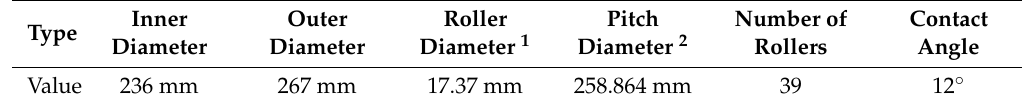
Figure 8. Two types of artificial defect on bearing: ( a ) spall on outer ring; ( b ) spall on roller Table 1. Parameters of bearing BG3-GP5.